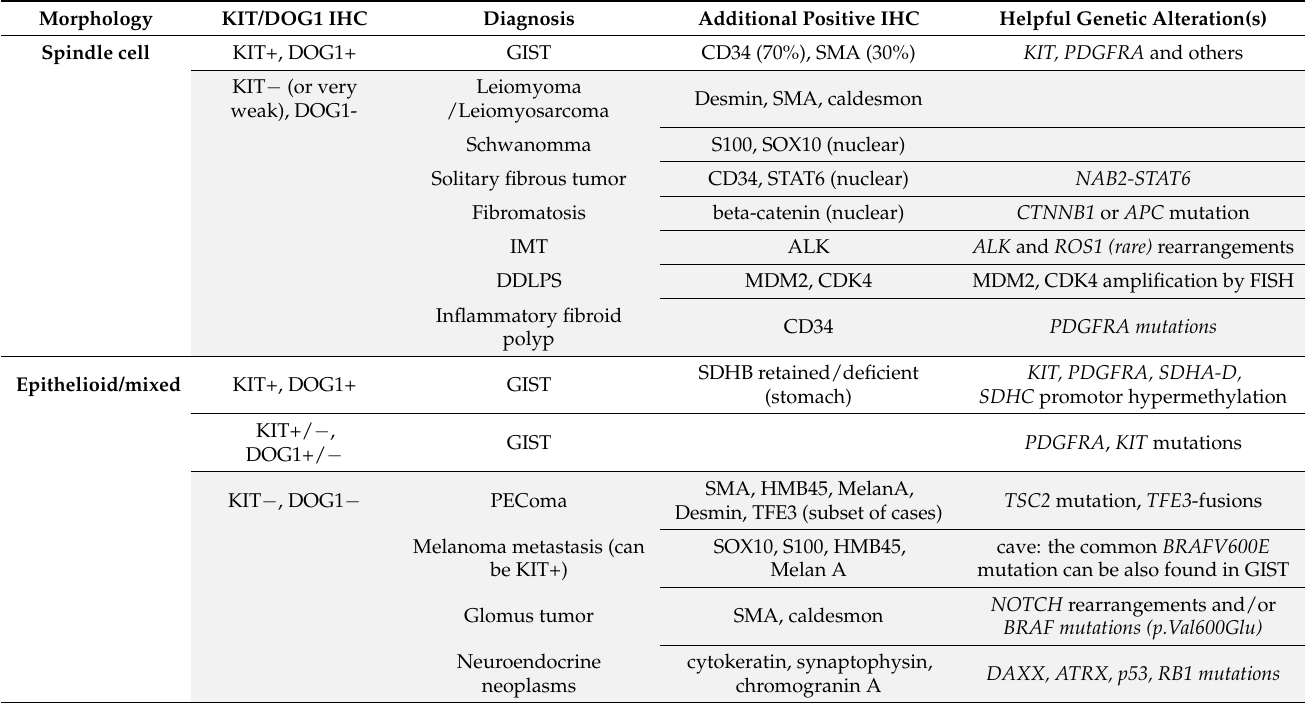
Table 1. Summary of the most frequent differential diagnosis for spindle cell, epithelioid and mixed GIST, including immunohistochemistry and molecular